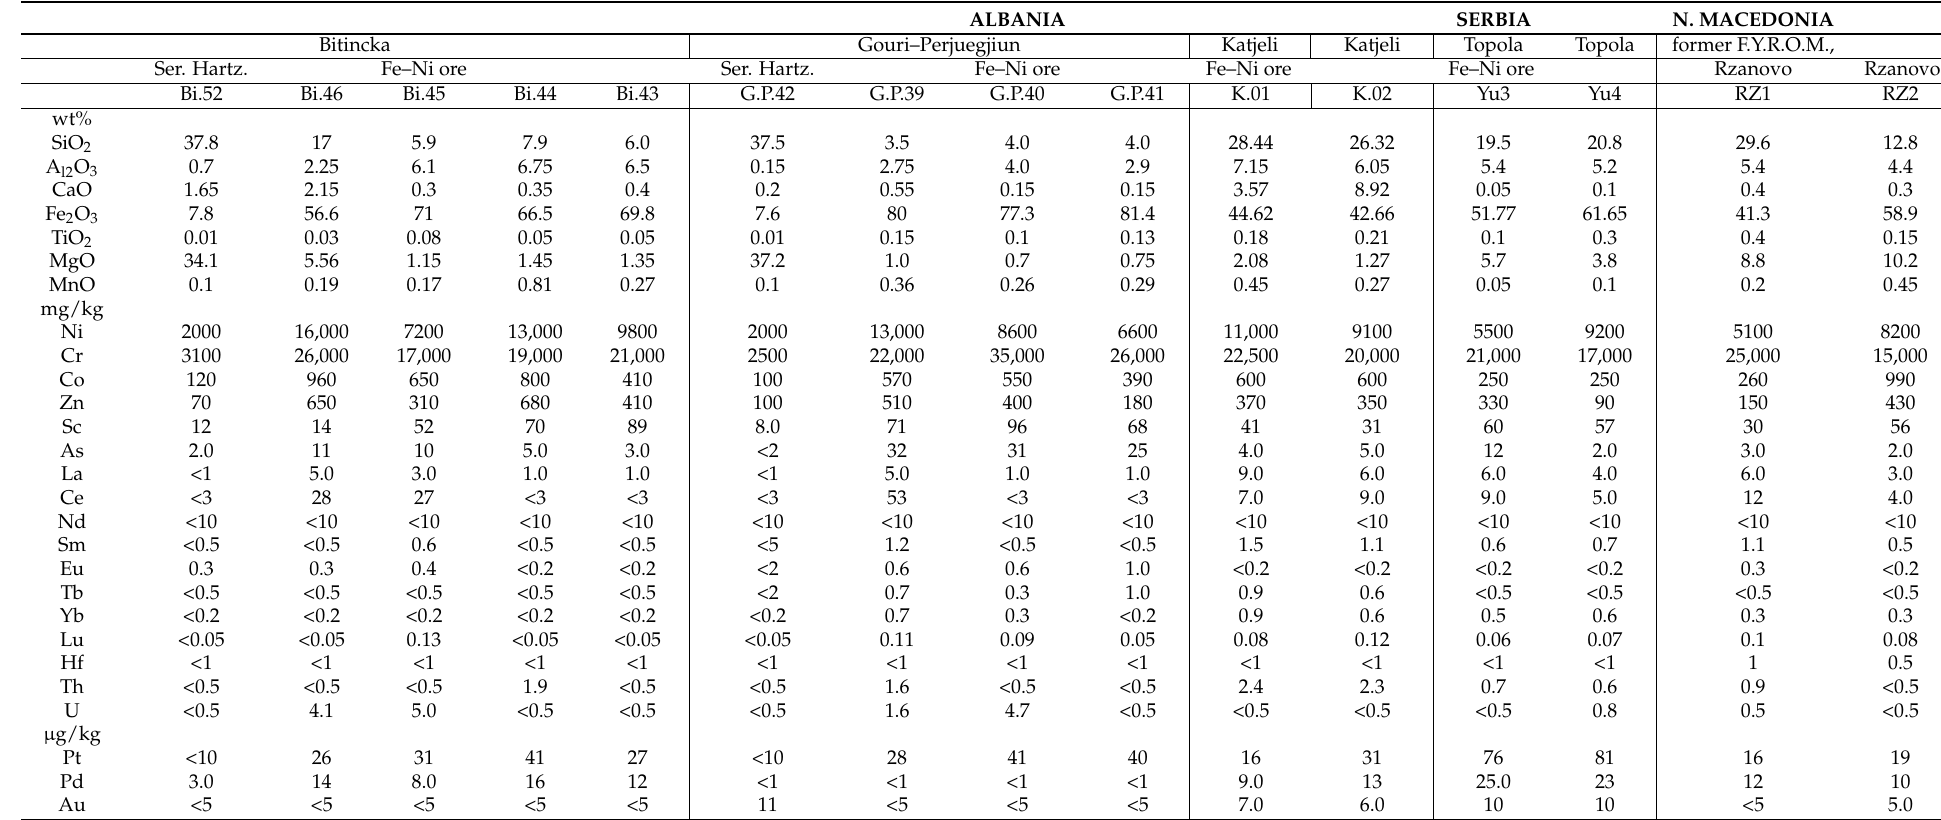
Table 5. Major and trace element contents in representative Fe–Ni ± Co laterite deposits from Albania, Serbia, and N. Macedonia (former